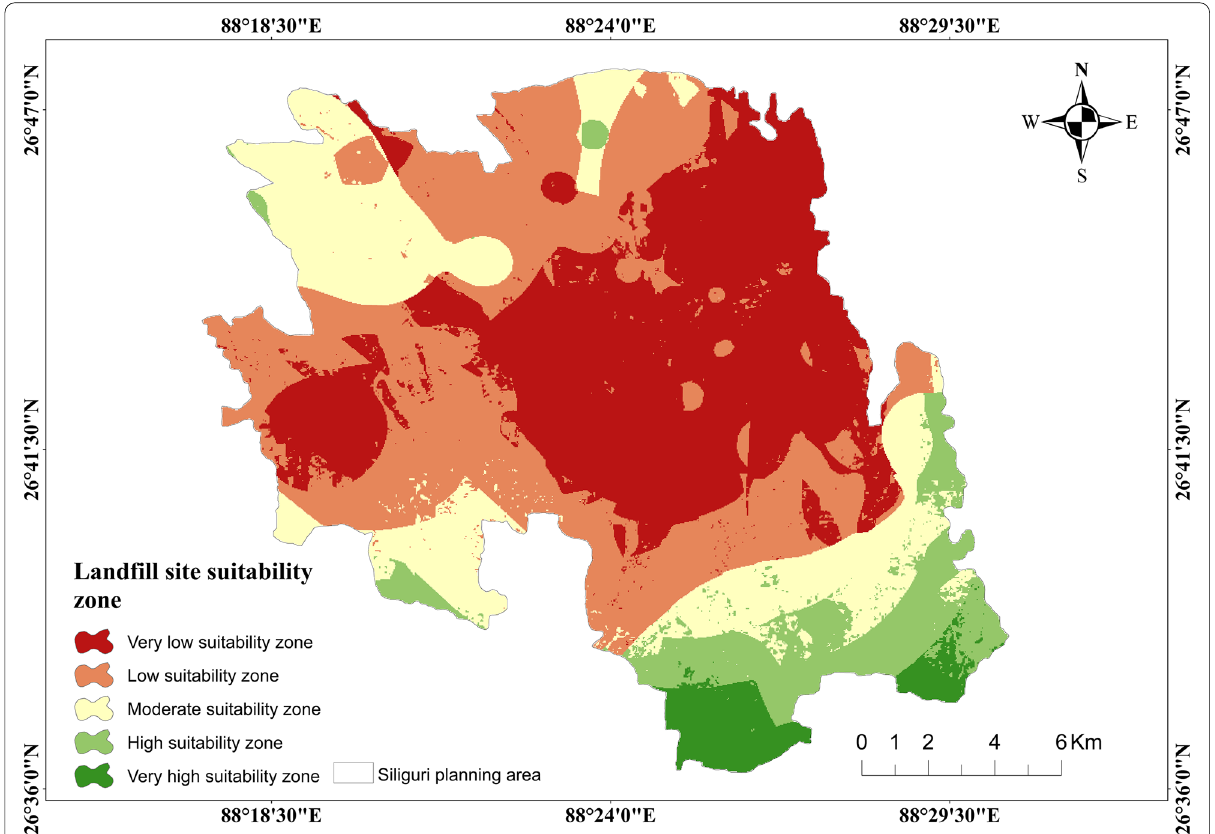
Fig. 6 Landfill site suitability zone in Siliguri Municipal Corporation Planning